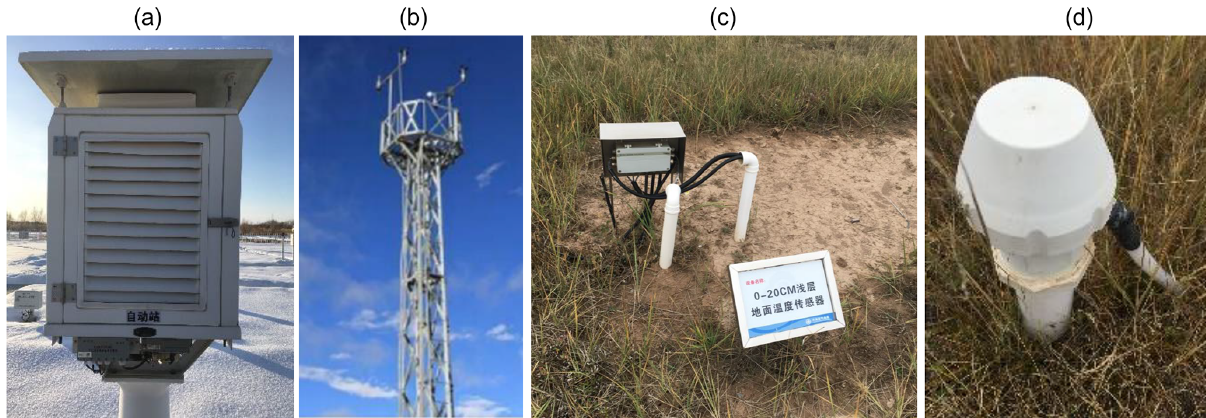
Figure 6. Instruments for observation of (a) air temperature and wetness, (b) wind speed, (c) soil temperature, and (d) soil